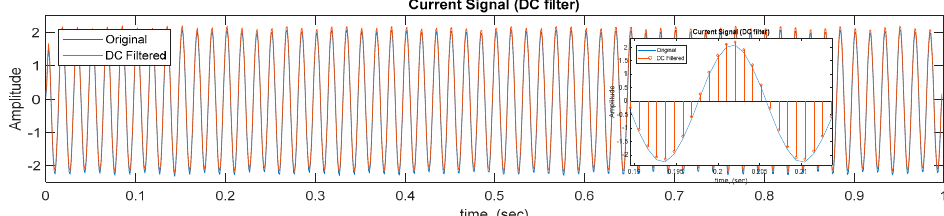
Figure 16. Downsampled low pass filtered and DC filtered current signal of measurement of motor line current of phase A at 60 Hz operation.